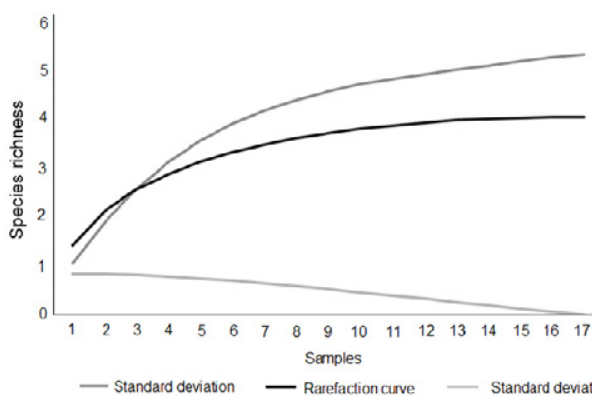
Fig 1. Rarefaction curve and standard deviation of the estimated richness in the 2008/2009 study in the campus of the Federal University of Juiz de Fora, southeastern Brazil.